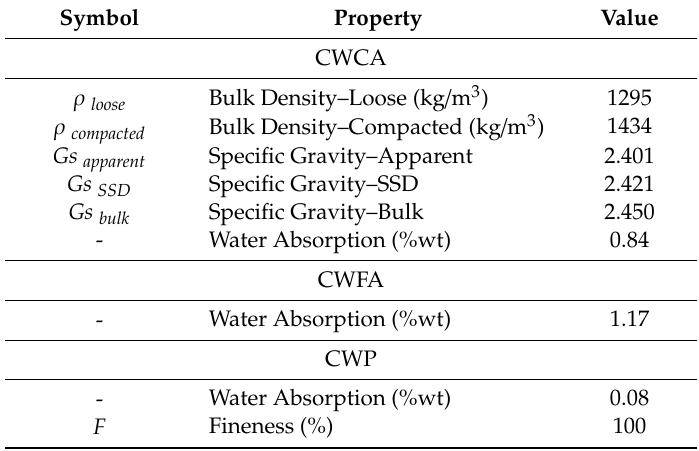
Table 1. Physical properties of ceramic additives.